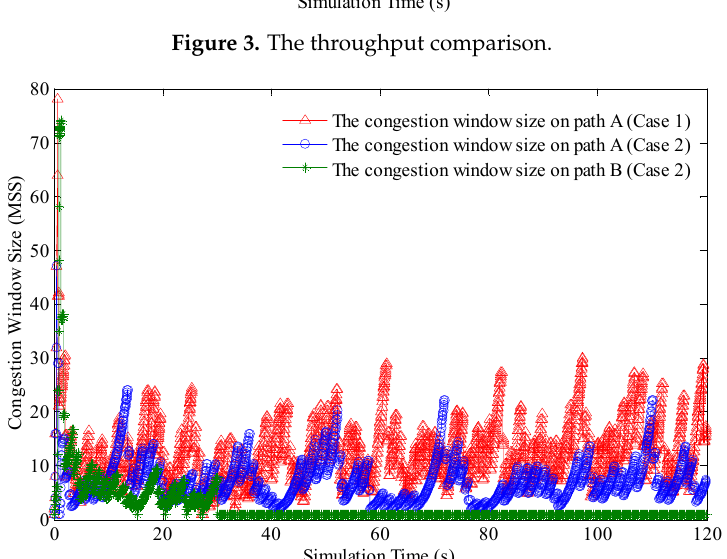
Figure 4. The congestion window comparison.